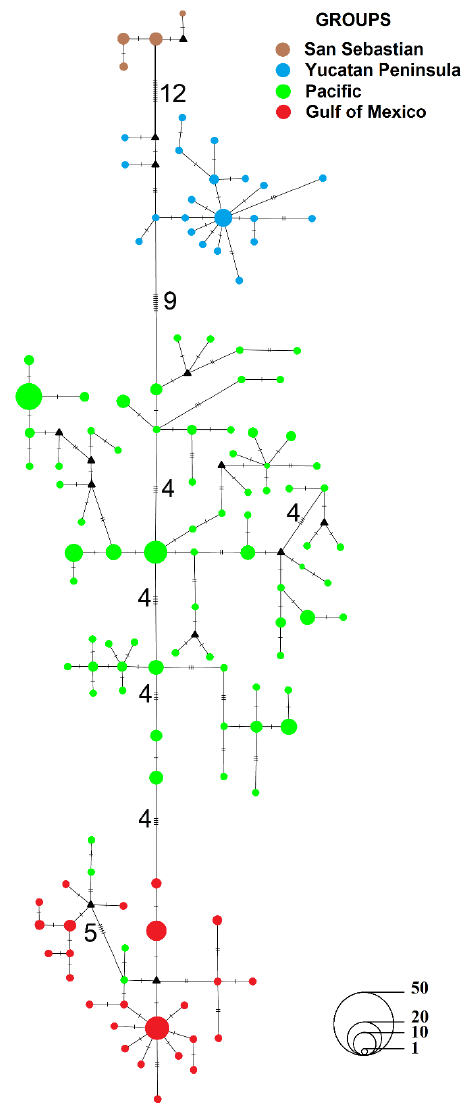
Figure 2. Median-joining network constructed from sequences from the mtDNA control region of Natalus mexicanus . The small lines connecting haplotypes indicate the mutation steps between them; small black triangles represent hypothetical haplotypes; the size of circles represents the frequency of each haplotype. Colors represent the following groups: Brown—San Sebastian; blue—Yucatan Peninsula; green—Pacific (included Pe locality); red—Gulf of Mexico. The lower right corner shows the scale for haplotype frequency.